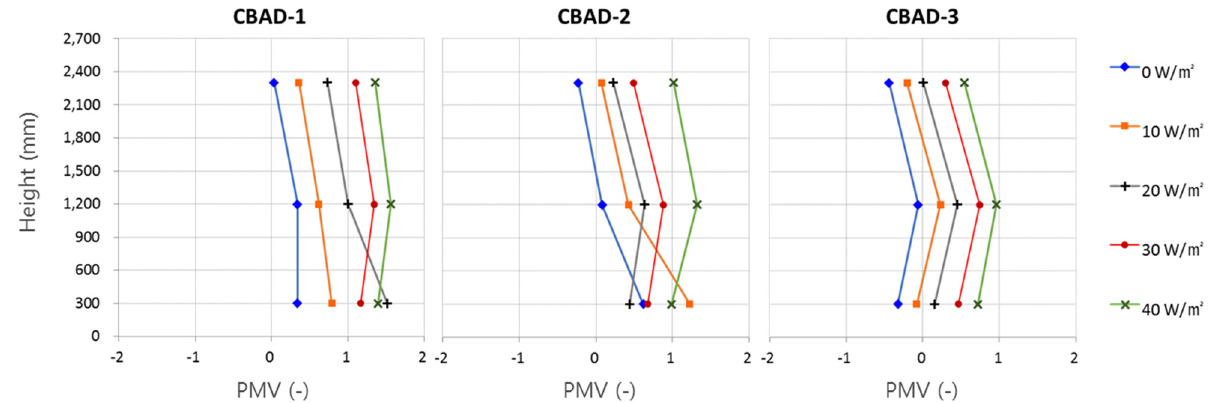
Figure 22. Vertical distribution of PMV at (X1, Y2),